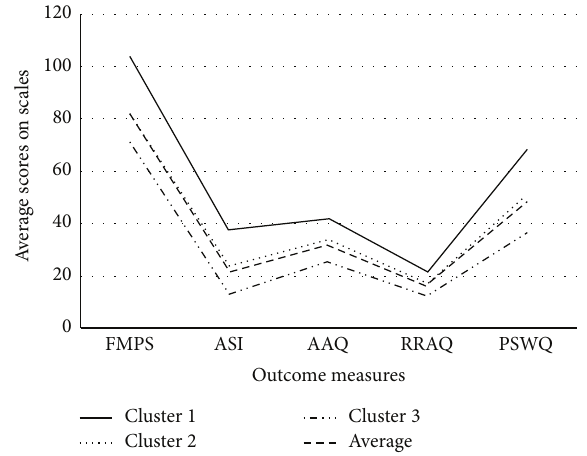
Figure 1: Distribution of dispositional traits among the 3 clusters. Note: AAQ = Action and Acceptance Questionnaire, ASI = Anxiety Sensitivity Inventory, FMPS = Frost Multidimensional Perfection- ism Scale, PSWQ = Penn State Worry Questionnaire, and RRAQ = Reactions to Relaxation and Arousal